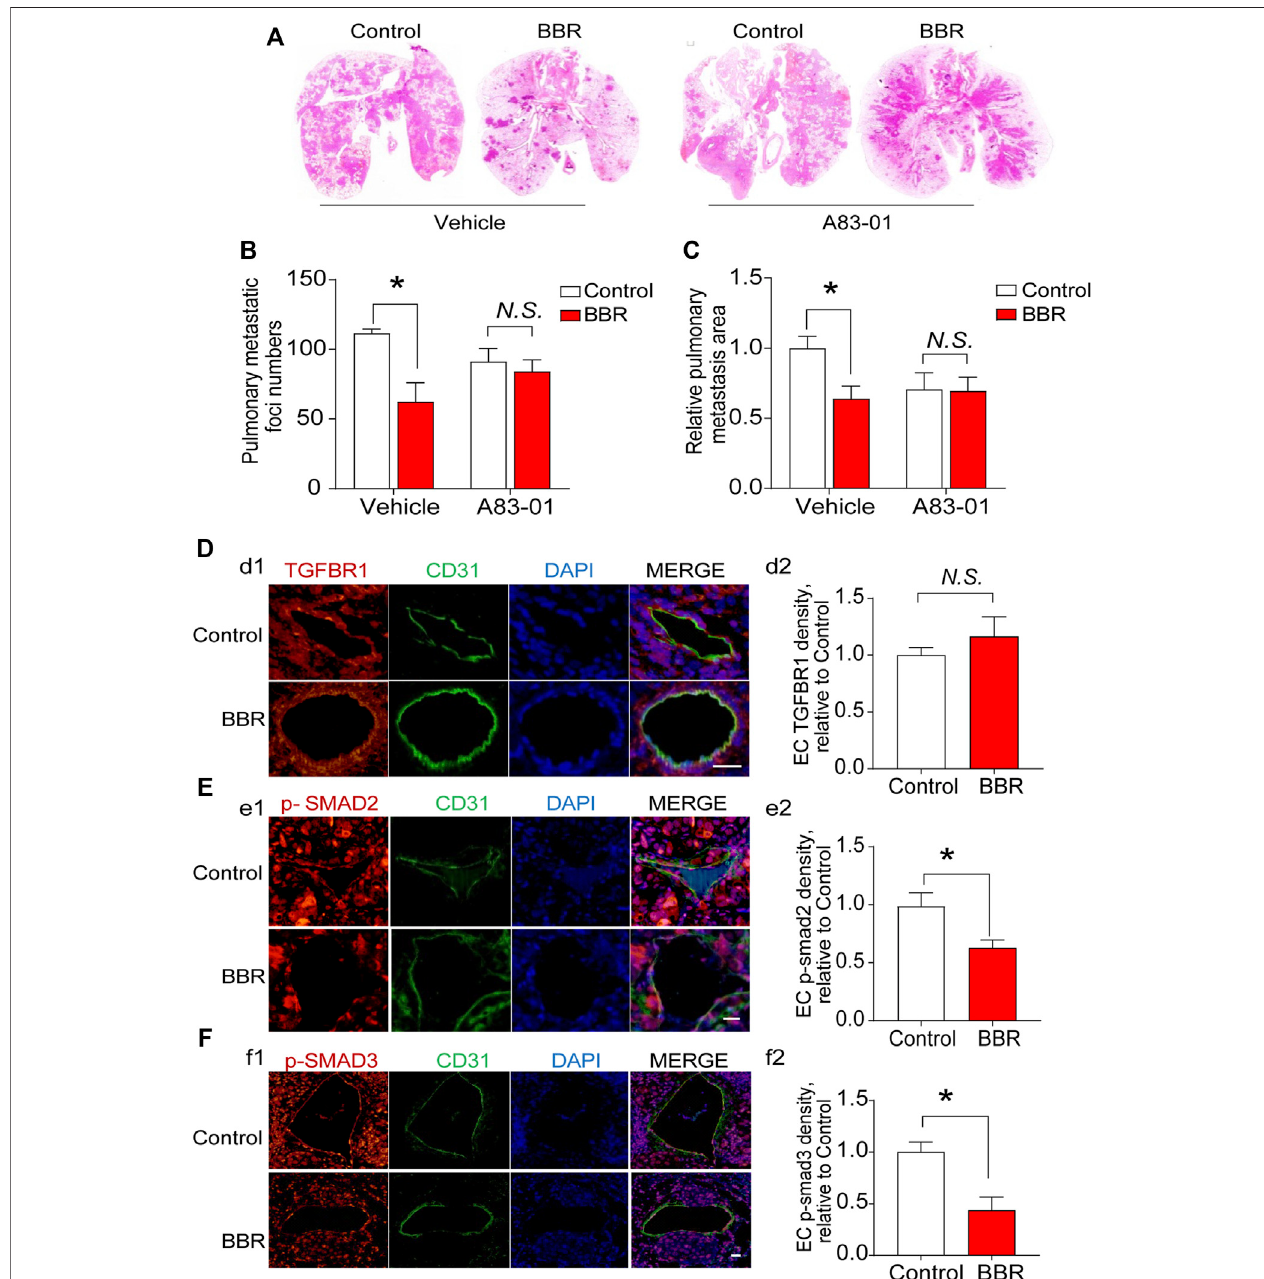
FIGURE 6 | TGFBR1 mediates the anti-metastatic effect of BBR in vivo (A) . Representative images, and (B) . statistical results of the number and (C) . area of lung metastatic foci. (D – F) Immuno fl uorescent staining and endothelial cells (CD31; green) was performed in pulmonary vessels of mice in control and BBR groups. DAPI stainsnuclei inblue. Representativeimmuno fl uorescent stainingimagesand statisticalresults oftheeffectsofBBRon endothelialTGFBR1 density (d1 – d2; red) ,SMAD 2/3 phosphorylation (e1 – e2, f1 – f2; red) . Scale bar = 25 μ m * p < 0.05; Student ’ s t -test; n = 5 in (D – F) .